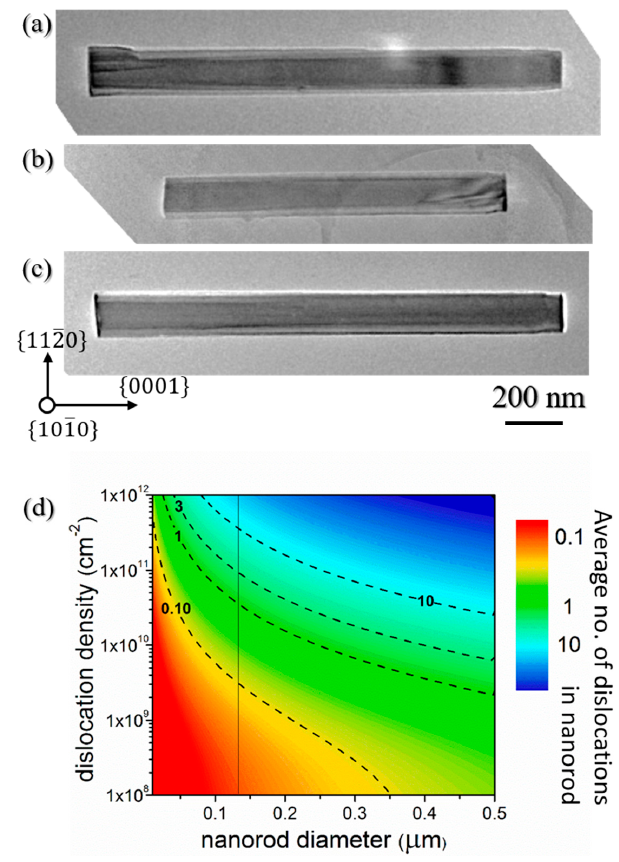
Figure 3. ( a – c ) TEM pictures of three different AlN etched nanorods acquired along the [1010] zone axis. The left and right hand-side of each image are related to the bottom and top of the nanorod, respectively. Note, the nanorod in ( b ) has been broken during mechanical removal and hence is shorter; ( d ) average number of dislocations from the template which remain in the nanorod, calculated for different etched nanorod diameters as a function of the dislocation density in the planar template. The dashed lines are contour lines to guide the eye. The vertical straight line corresponds to a nanorod diameter of 130 nm.